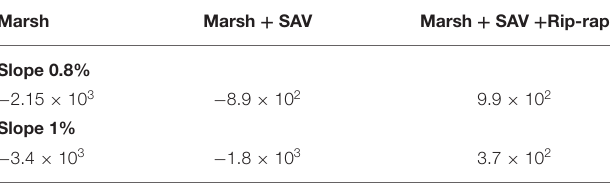
TABLE 3 | Average sediment budget for the three different scenarios. Marsh Marsh + SAV Marsh + SAV +